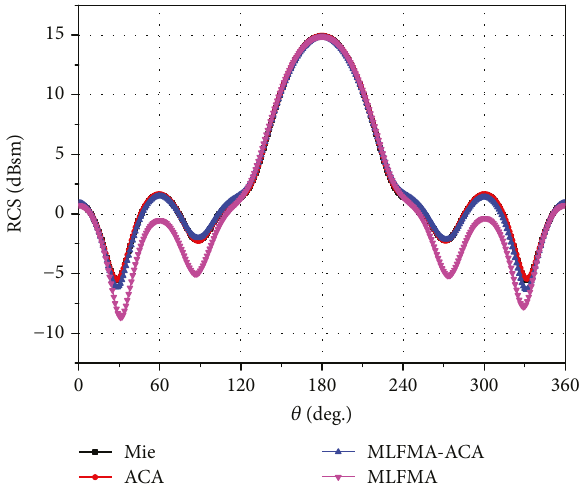
Figure 8: Bistatic RCS in VV polarization from a coated dielectric sphere with the relative permittivities of ε r = 4 0 – 0 2 j , an inner radius of r and ε r 2 = 0 5 m radius of r 2